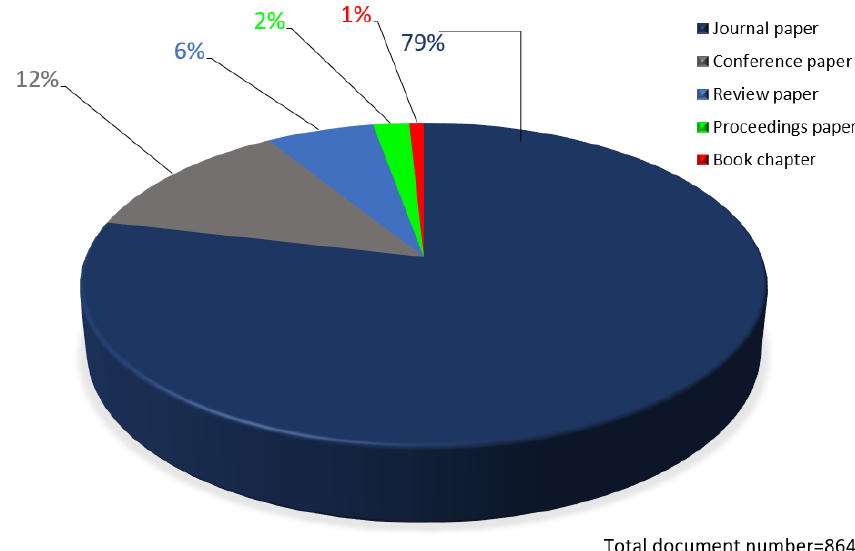
Figure 3. Distribution of publications.